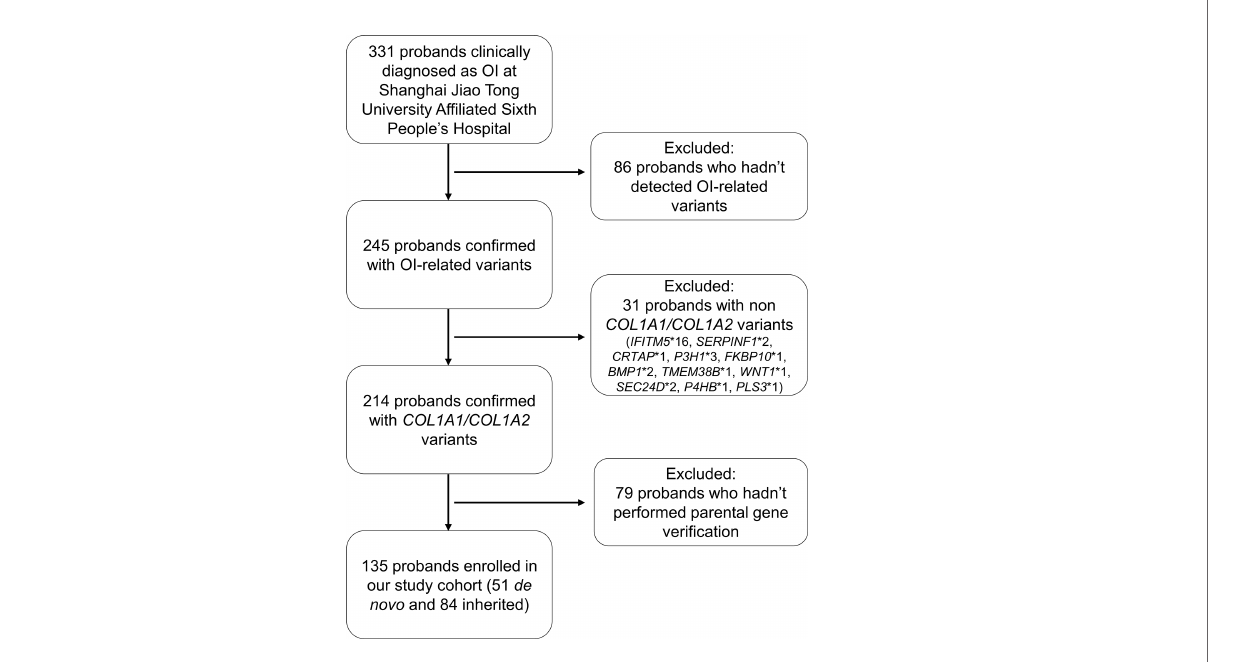
FIGURE 1 | Flowchart of study cohort